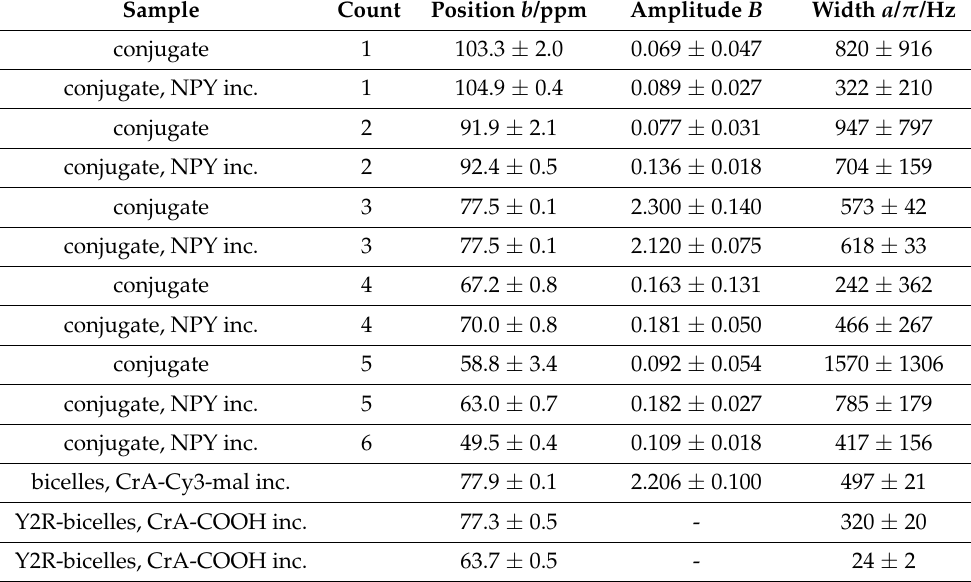
Table 1. Parameters fitted to the z-spectra of conjugate alone and in complex with NPY as superposi- tion of 5 and 6 individual resonances, respectively. For comparison, the parameters of hpXe bound to the free CrA-Cy3-mal construct incubated in a buffer solution of bicelles and those of hpXe bound to free CrA-COOH incubated in a buffer solution of Y2R embedded in bicelles are listed. Sample Count Position b /ppm Amplitude B Width a/ π /Hz